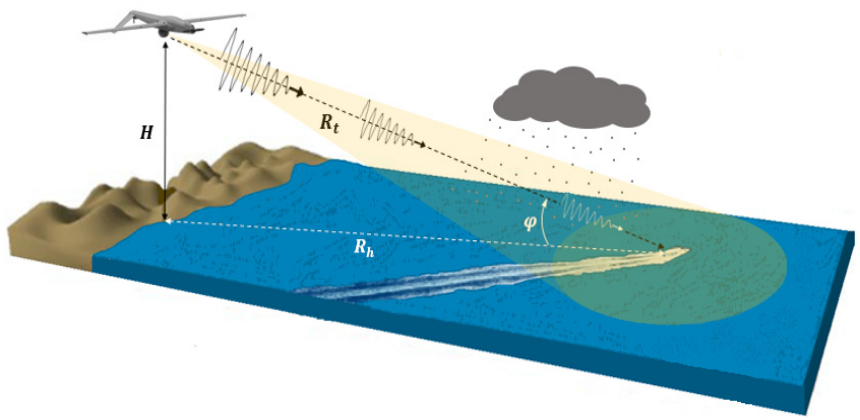
Figure 3. EM wave propagation attenuation by atmospheric factor.